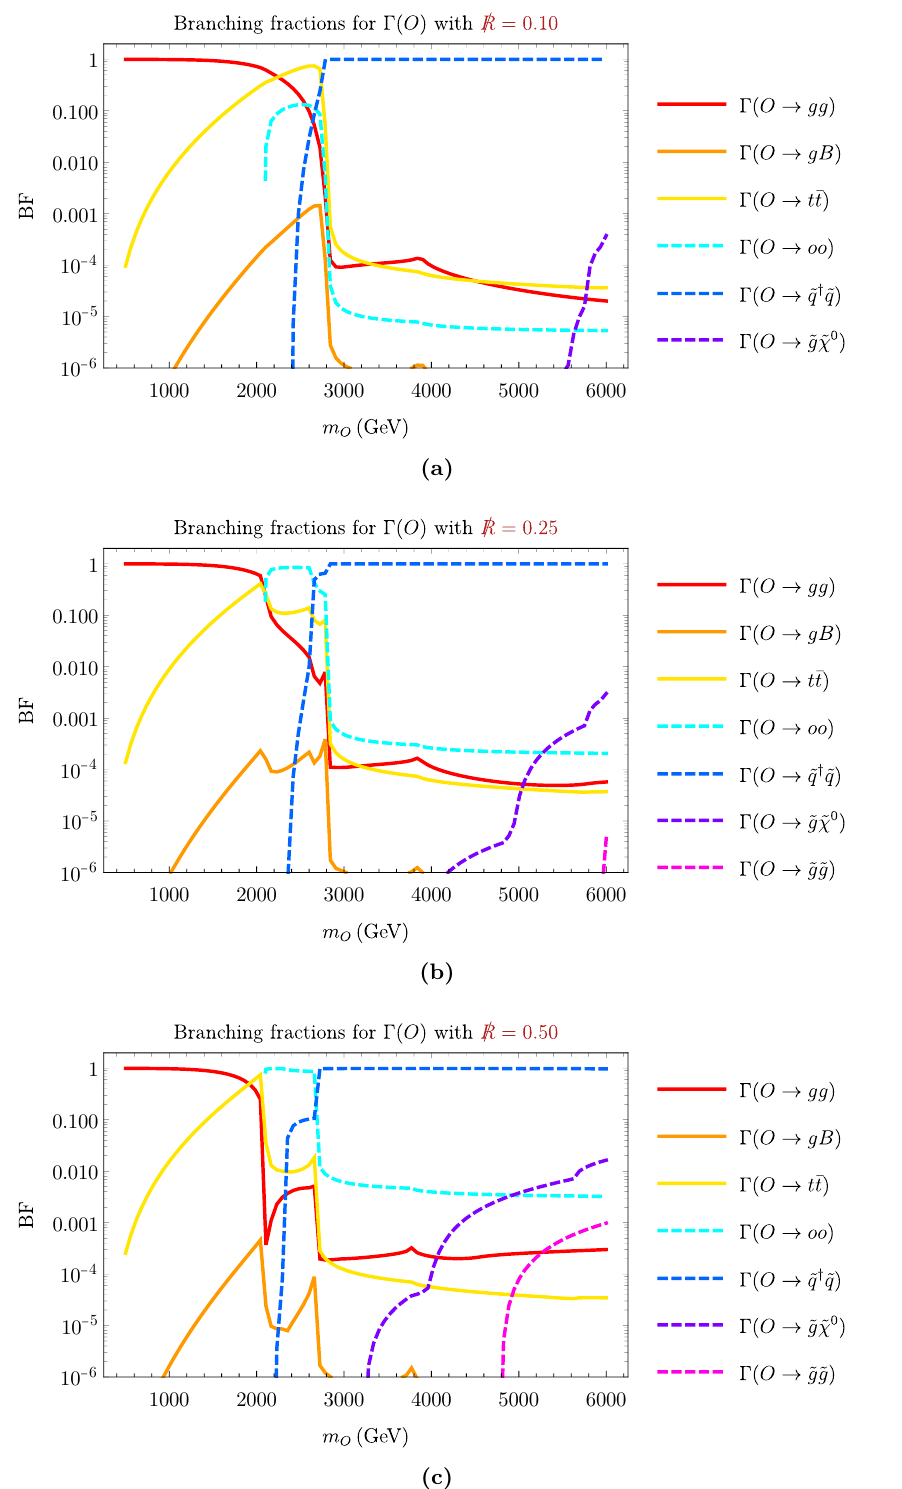
Figure 7. Branching fractions for the scalar sgluon in (a) Benchmark 1, with /R = 0.10 ; (b) Benchmark 2, with / R = 0.25 , and (c) Benchmark 3, with / R = 0.50